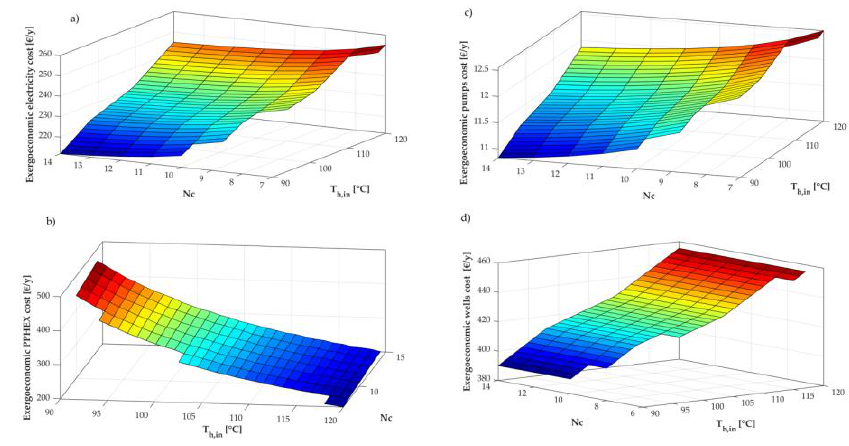
Figure 10. Effect of Nc and T h , in on the exergoeconomic costs of electricity ( a ), on PPHEX purchase cost ( b ), on pumps purchase cost ( c ), and on well investment cost ( d ). Figure 10 . Effect of Nc and 𝑇 ℎ,𝑖𝑛 on the exergoeconomic costs of electricity (a), on PPHEX purchase cost (b), on pumps purchase cost (c), and on well investment cost (d).